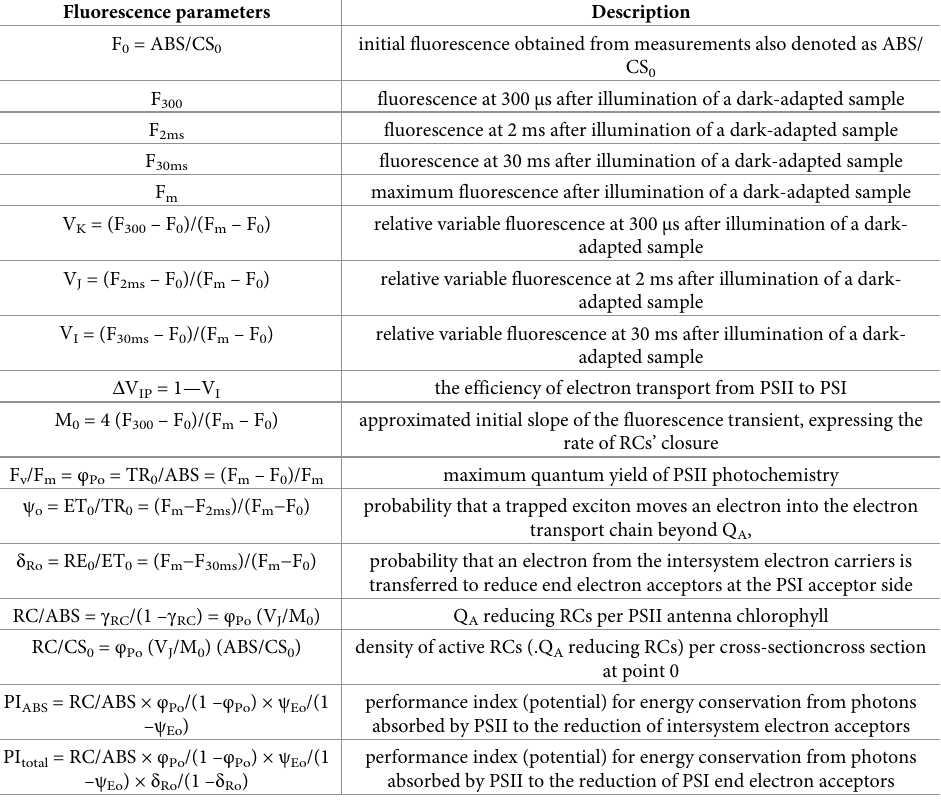
Table 1. Description of chlorophyll-a fluorescence